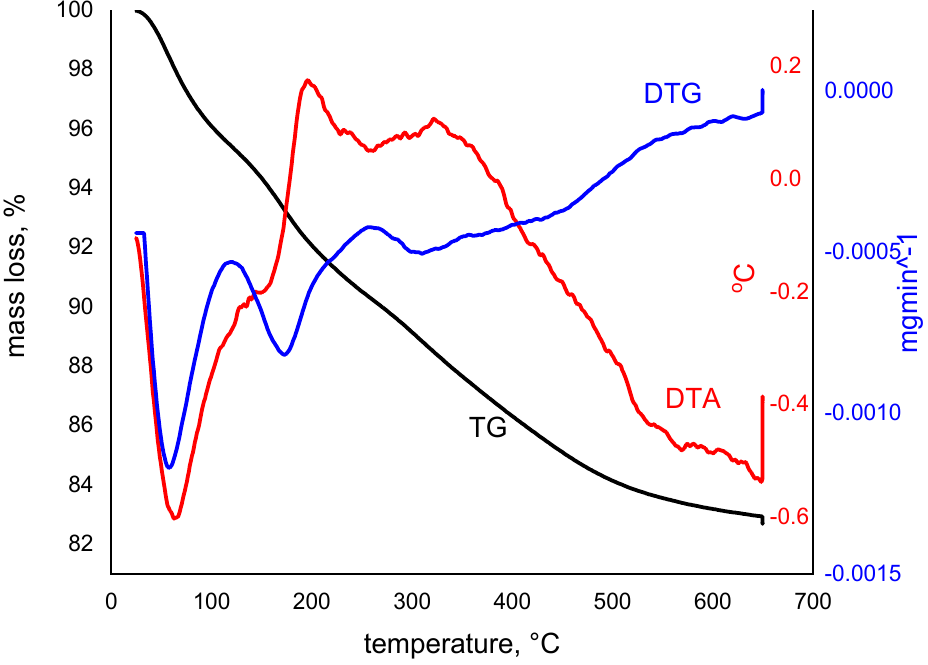
Figure 4. TG, DTG and DTA curves, obtained for thermal degradation of xerogel sample, SiO 2 Fe x O y , at heating rate of 5 °C min − 1 in air.